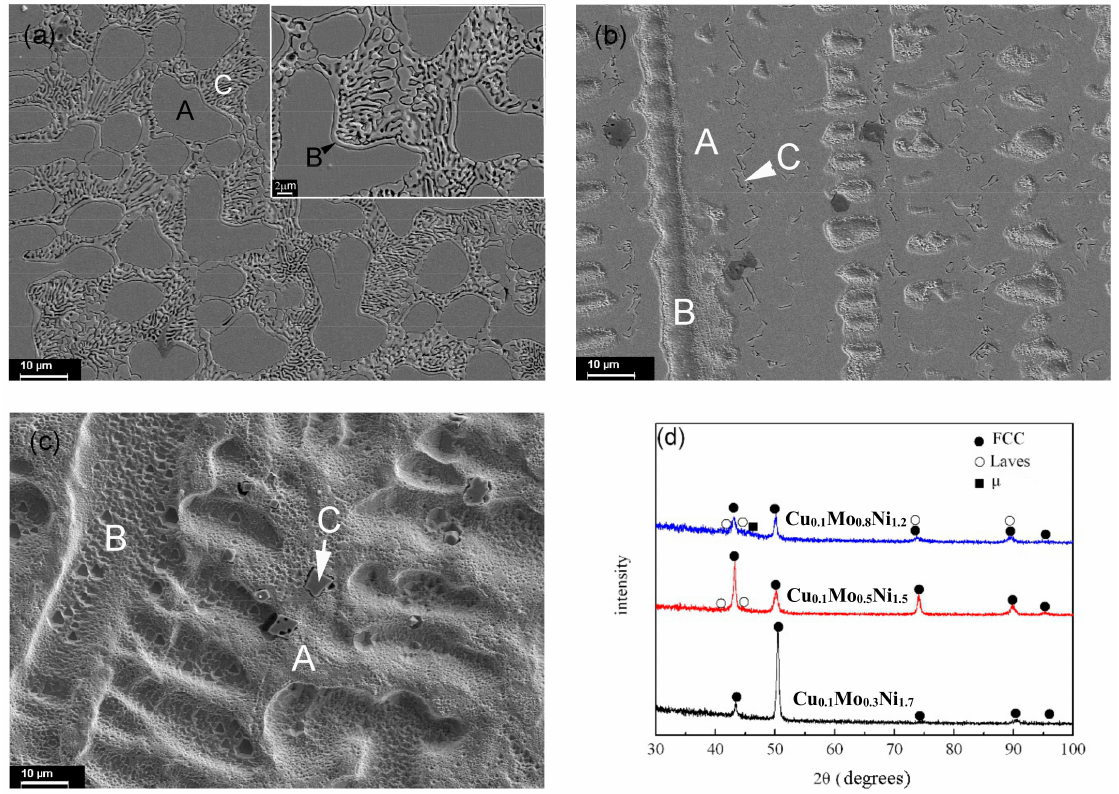
Figure 4. Microstructures and XRD patterns of the CoCrCu 0.1 FeMo 2 − d Ni d HEAs. ( a ) Cu 0.1 Mo 0.8 Ni 1.2 ; ( b ) Cu 0.1 Mo 0.5 Ni 1.5 ; ( c ) Cu 0.1 Mo 0.3 Ni 1.7 ; ( d ) XRD